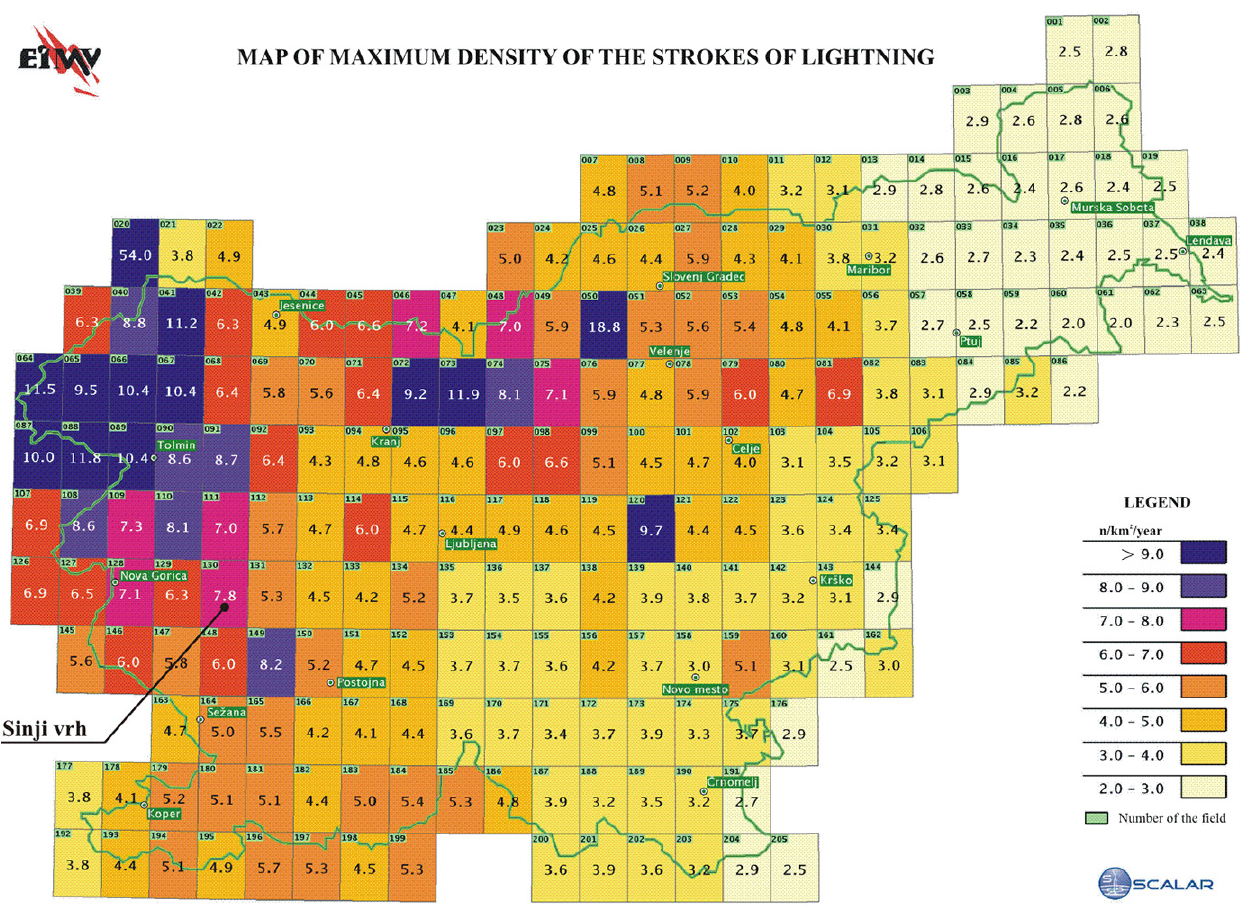
Figure 1. Map of the maximum yearly number of lightning strokes per km 2 in Slovenian